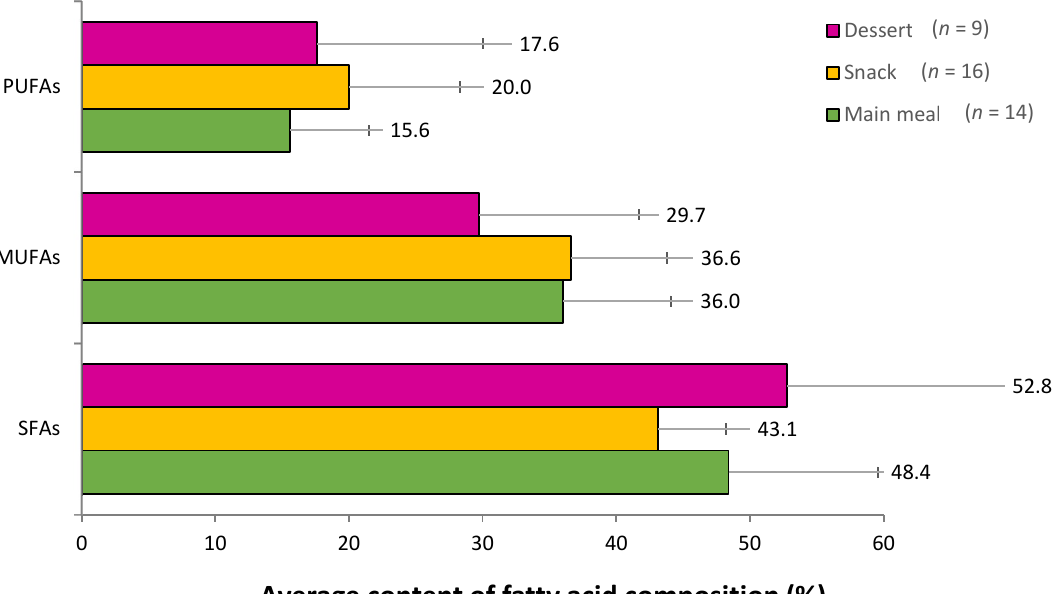
Figure 1. The average fatty acid (FA) composition from 39 street foods based on food category. PUFAs, MUFAs, and SFAs are the abbreviations for polyunsaturated fatty acids, monounsaturated fatty acids, and saturated fatty acids, respectively.